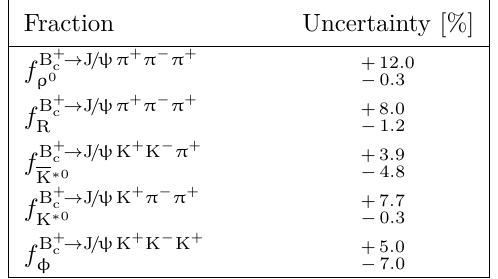
Table 4 . Systematic uncertainties for the fractions of the decays via